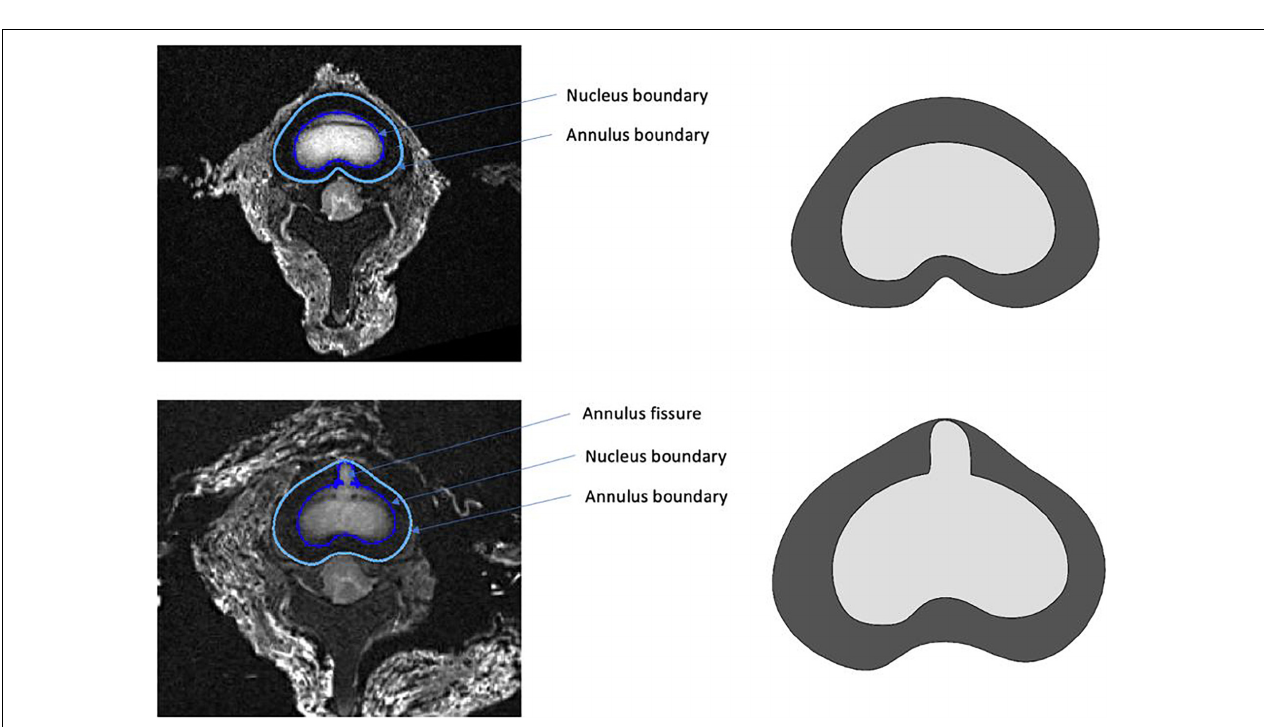
FIGURE 3 | Method to calculate global nucleus sagittal displacement. Panel (A) is the reference mechanical loading state, i.e., step 1. Panel (B) is the studied mechanical state, i.e., step 2 to 6 ( Table 1 ). C np is the centroid of the nucleus pulpous; C sc is the centroid of the spinal cord; d 0 is the reference distance; d is the distance of the studied mechanical state.